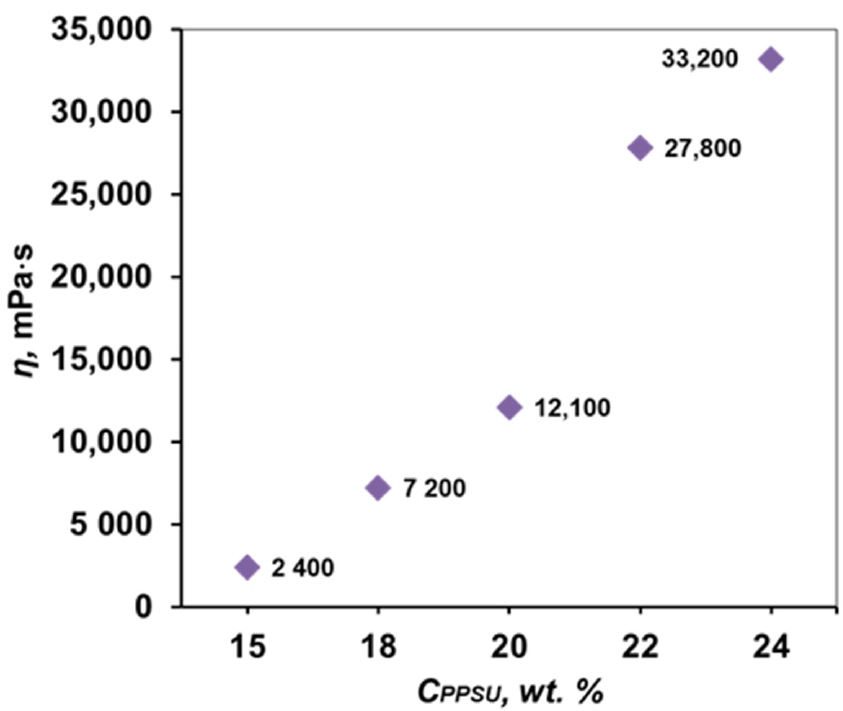
Figure 5. Dependences of the viscosity of PPSU 5 solutions in NMP on its concentration at 22 °C.